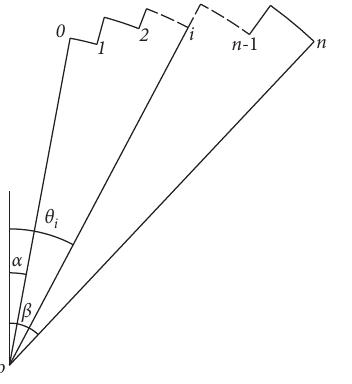
Figure 3: Unit step function diagram.